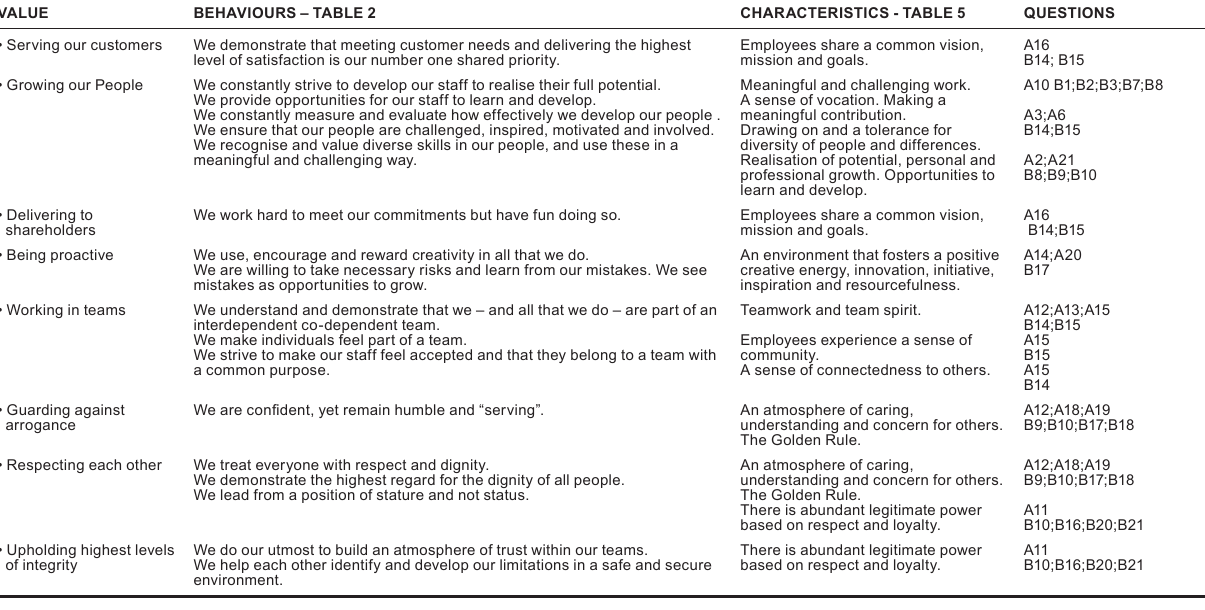
TABLE 6 Linking values, behaviours and characteristics of spirituality at work